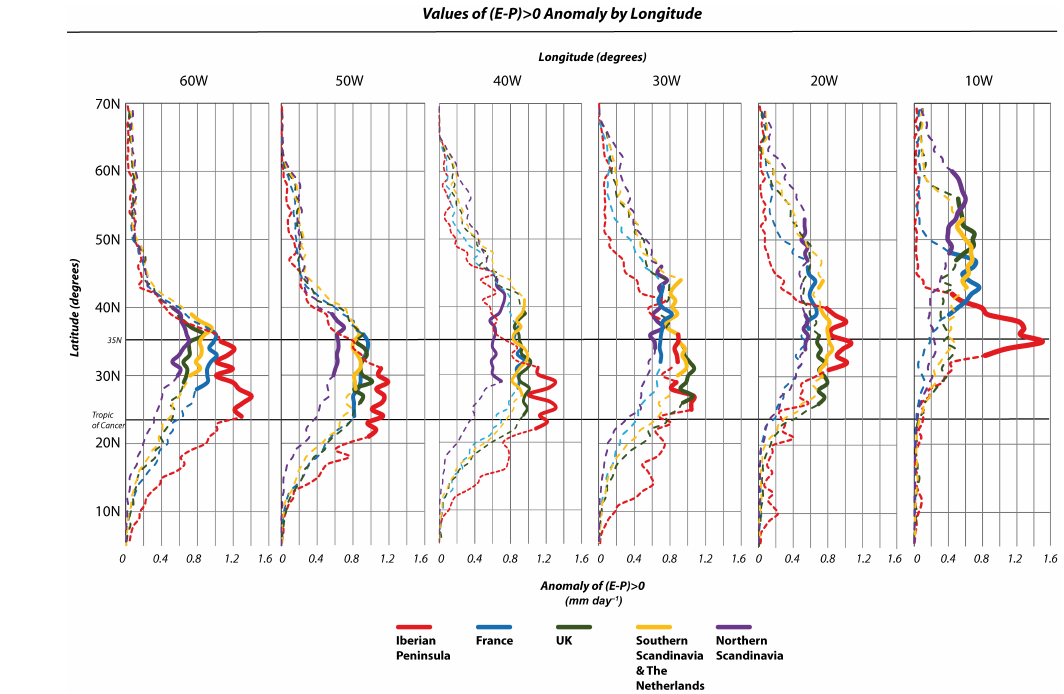
Figure 5. Longitudinal cross section of the anomaly values of ( E − P ) > 0 field [( E − P ) An ] for each studied domain: Iberian Peninsula (red line), France (blue), UK (green), southern Scandinavia and the Netherlands (yellow), and northern Scandinavia (purple). The bold line shows those values over the 90th percentile of each series (values shown in Table 4). Units in mmday − 1 . The Tropic of Cancer parallel (23.43 ◦ N) and the 35 ◦ N parallel are also